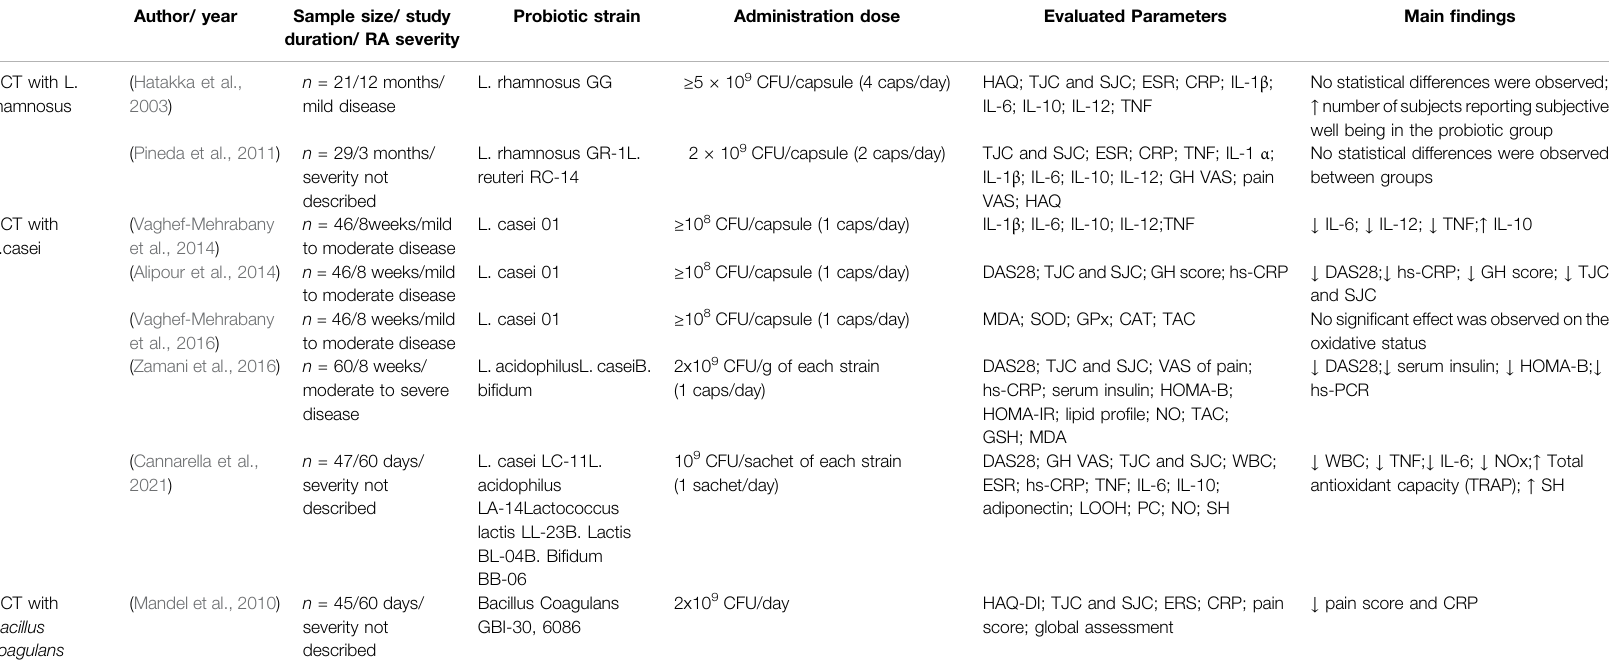
TABLE 2 | Probiotic effects on Rheumatoid Arthritis in clinical